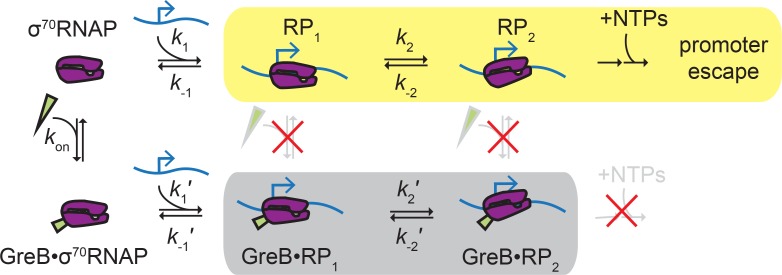
Proposed ‘delayed inhibition’ mechanism for growth-dependent regulation of rRNA initiation.σ70RNAP (purple) binds promoter DNA (blue) and forms closed complexes RP1 and RP2 before isomerization to open complex, initial transcript synthesis, and promoter escape in the productive initiation pathway (yellow). GreB (green) binds rapidly and reversibly to free σ70RNAP (Table 1), and GreB does not alter the kinetics of closed complex formation or decay (Table 4). However, GreB blocks a later step in initiation and GreB dissociation from RNAP cannot compete with RNAP dissociation from the promoter; thus, promoter binding by GreB•σ70RNAP is a non-productive pathway (gray) that does not initiate RNA synthesis. DksA likely regulates rRNA initiation by a similar mechanism.